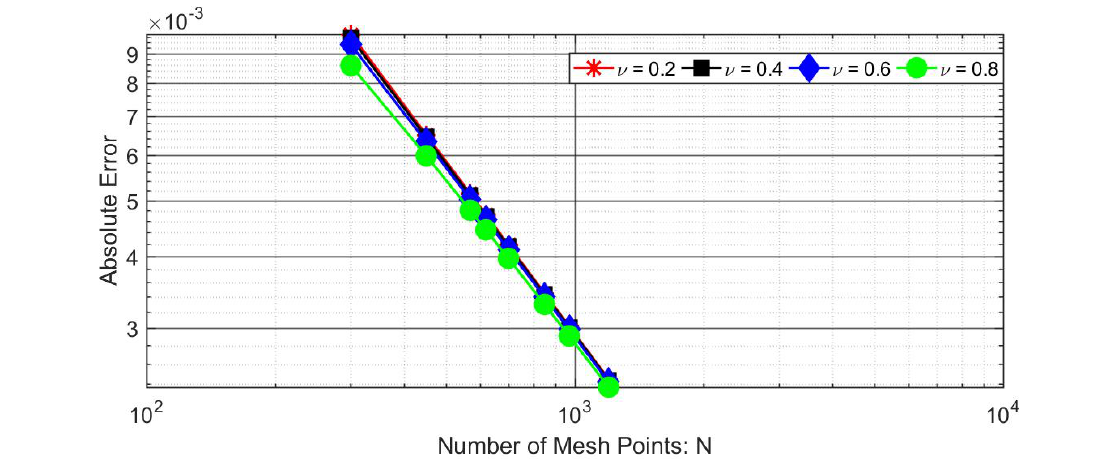
Figure 6. Logarithmic plot of absolute errors vs. number of mesh points for Problem